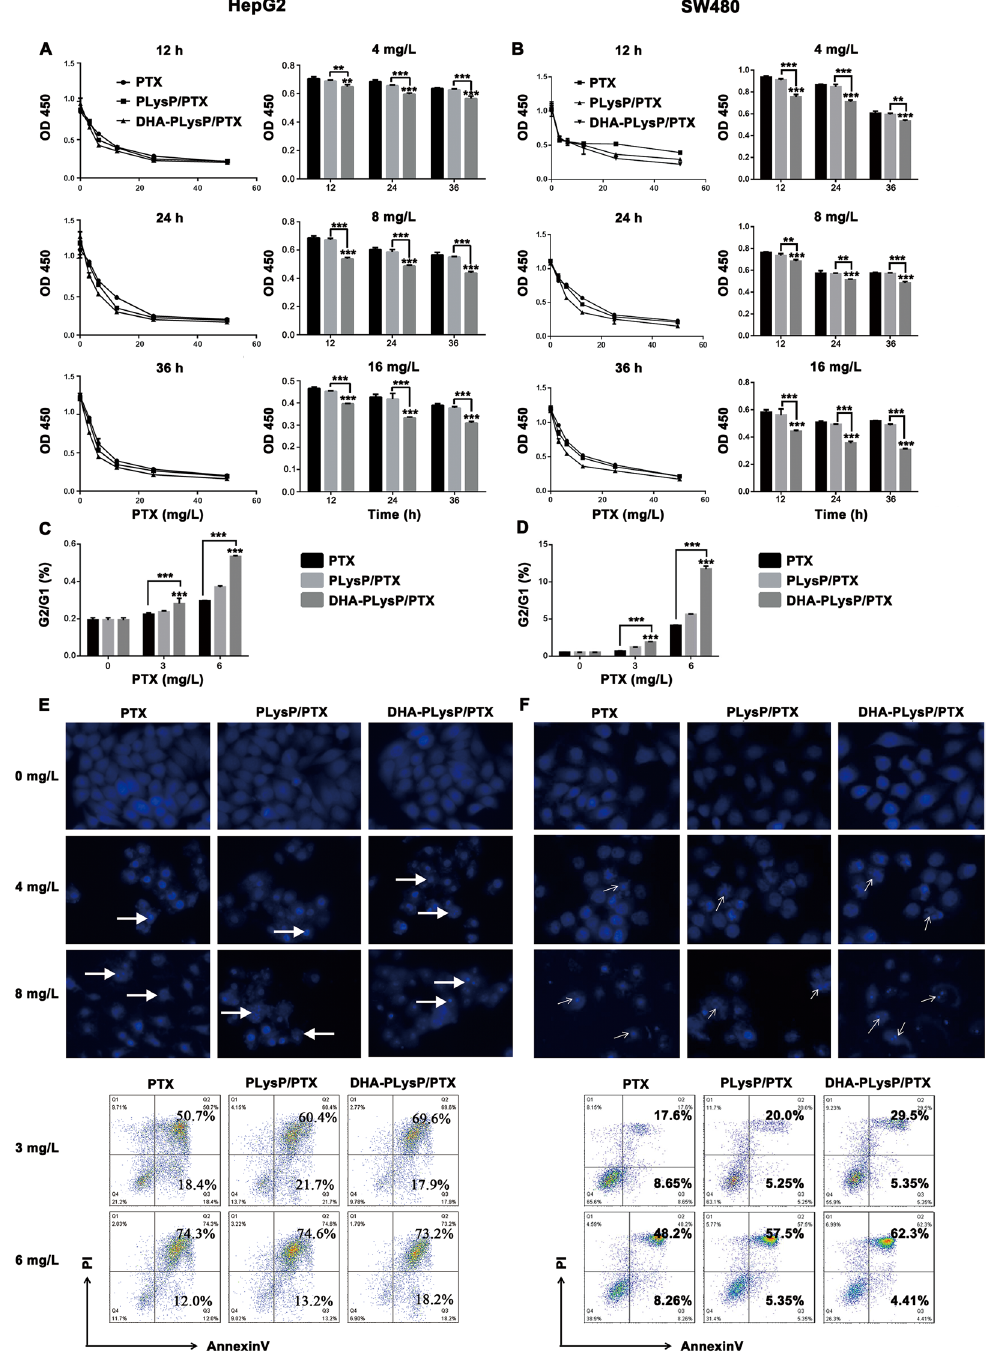
Figure 3. Proliferation inhibition and apoptosis induction of the HepG2 and SW480 cells under the treatment of free PTX, PLysP/PTX or DHA-PLysP/PTX. ( A,B ) The proliferation of HepG2 and SW480 cells under the treatment of PTX, PLysP/PTX and DHA-PLysP/PTX micelles with different dose of PTX for different time were detected at OD 450 nm. Six replicates each. ( C,D ) HepG2 and SW480 cells were treated with PTX, PLysP/ PTX and DHA-PLysP/PTX micelles for 24 h, and then were stained by propidium iodide and analyzed by flow cytometry. The ratio of cells in G2 phase to those in G1 phase was shown. ( E,F upper) HepG2 and SW480 cells were treated with PTX, PLysP/PTX and DHA-PLysP/PTX micelles at the final PTX concentration of 4 mg/L and 8 mg/L for 24 h and stained with DAPI to check the morphological changes of nucleus (magnification × 200). Nuclear fragmentation and chromatin condensation are indicated by white arrows. ( E,F lower) HepG2 and SW480 cells were treated with PTX, PLysP/PTX and DHA-PLysP/PTX micelles at the final PTX concentration of 3 mg/L and 6 mg/L for 24 h and then were stained by Annexin V and PI before subjected to FACS for cell apoptosis analysis. ** p < 0.01, *** p <